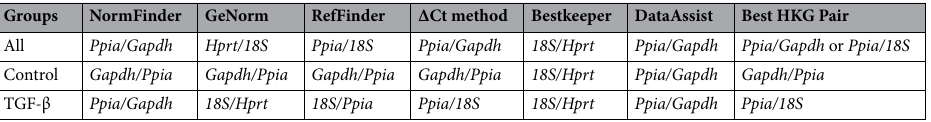
Table 1. The best combination of housekeeping genes for each group of samples yielded by software analysis. All, all samples. HKG, housekeeping genes.